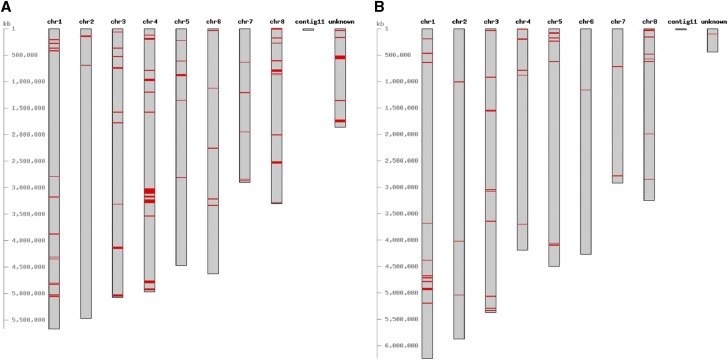
Chromosomal location of genes encoding morphotype-unique proteins (shown in red). Figures were created using CViT (Cannon and Cannon 2011). (A) Genes encoding S morphotype-unique proteins mapped on the pseudogenome of AZS. (B) Genes encoding L morphotype-unique proteins mapped on the pseudogenome of DV901.